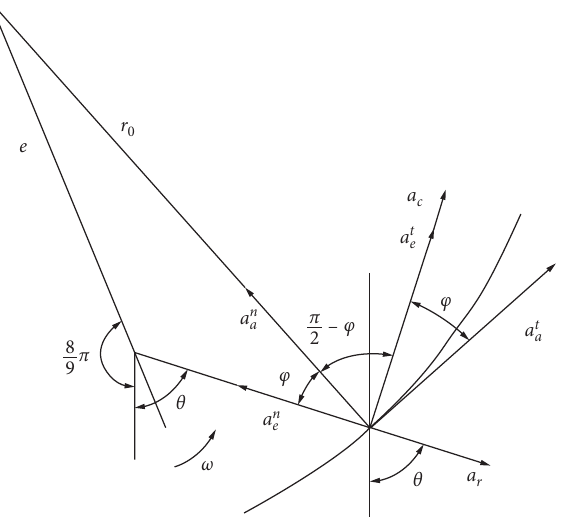
Figure 8: Analysis of cotton seed acceleration.